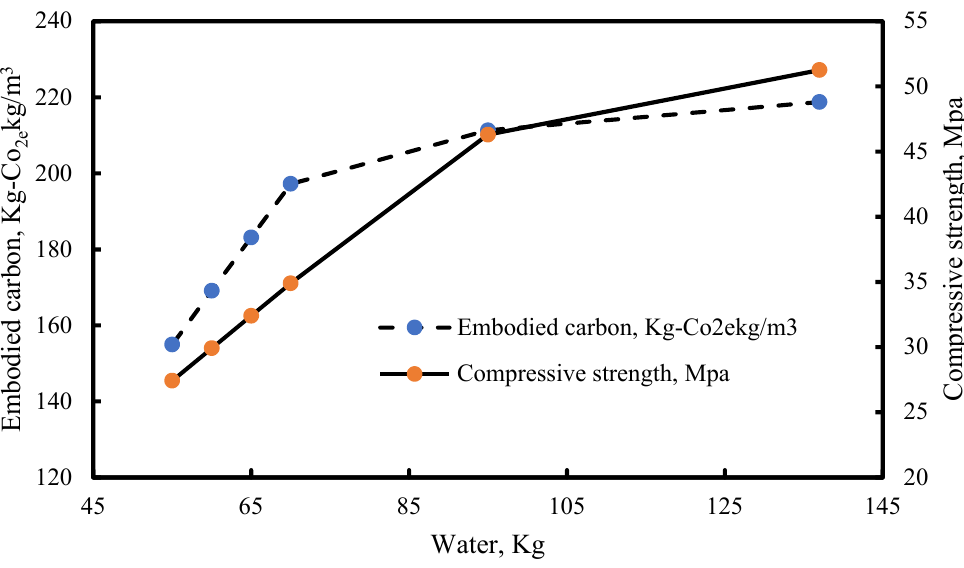
Figure 10. LCC at optimal water content of 85-105 litres per m 3 of concrete [33]. The same observation is shown in Figures 11–14 with an optimal water content of 80 kg, 95 kg, 80 kg and 60 kg, respectively.